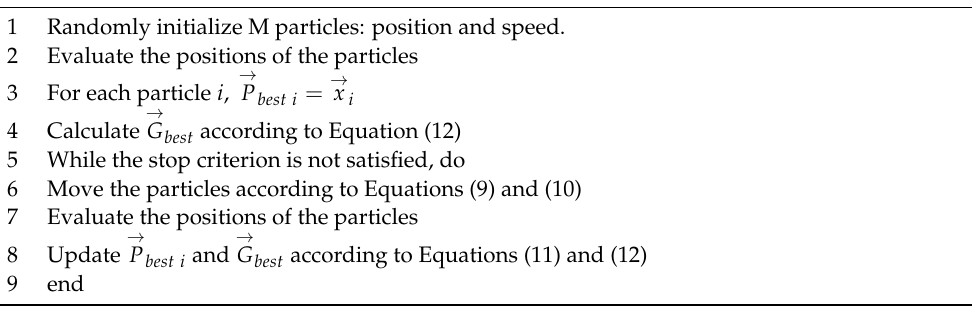
Algorithm 1. The procedure of corresponding flowchart